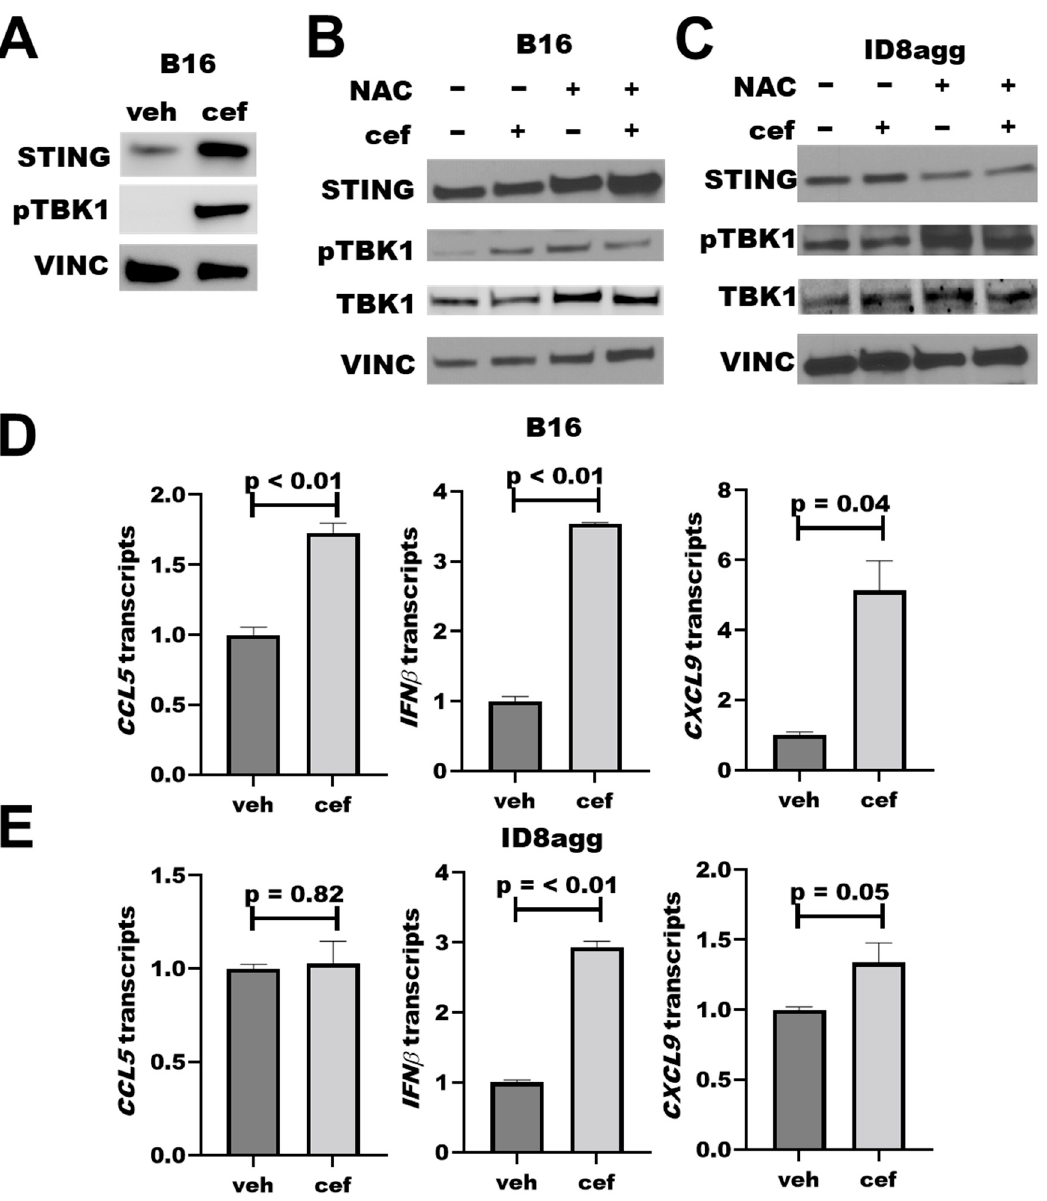
Figure 5. Cefepime promotes tumor STING activation. ( A ) Immunoblot for STING, phospho-TBK1 (pTBK1), and loading control vinculin (VINC) of B16 cells treated with DMSO or 80 µ M cefepime (cef) for 24 h. ( B ) Western blot for STING, pTBK1, total TBK1, and loading control vinculin in B16 cells treated with 80 µ M cefepime and/or 0.5 mM N-acetyl-L-cysteine (NAC) for 48 h. ( C ) Immunoblot for targets as in ( B ) in ID8agg cells treated with 80 µ M cefepime and/or 0.5 mM N-acetyl-L-cysteine for 48 h. ( D ) RT-qPCR assessment of normalized gene expression in B16 cells treated as in ( B ). p values by unpaired t test. ( E ) RT-qPCR assessment of normalized gene expression in ID8agg cells treated as in ( C ). p values by unpaired t test.